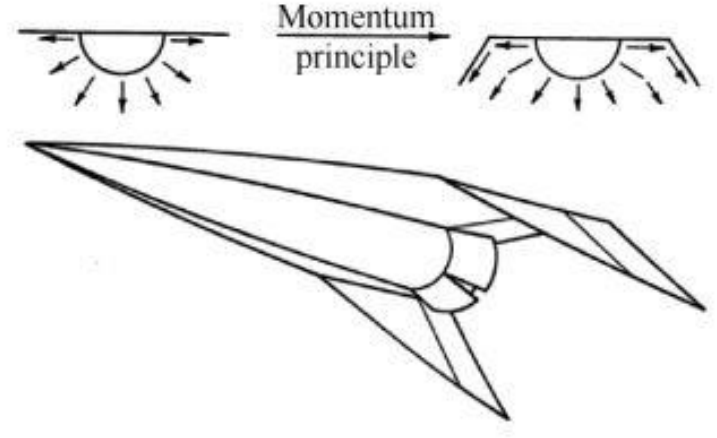
Figure 6. Modified “flat-top” configuration.